Question: Judging by this figure, is the value going up or going down?
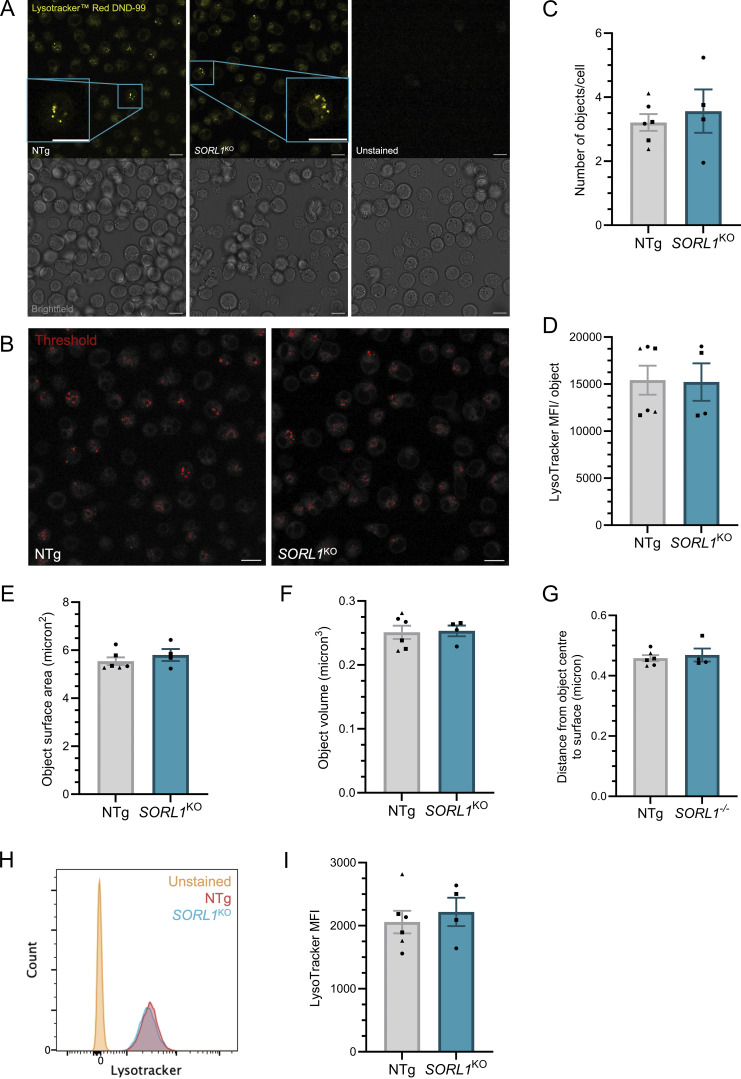
Answer: increasing